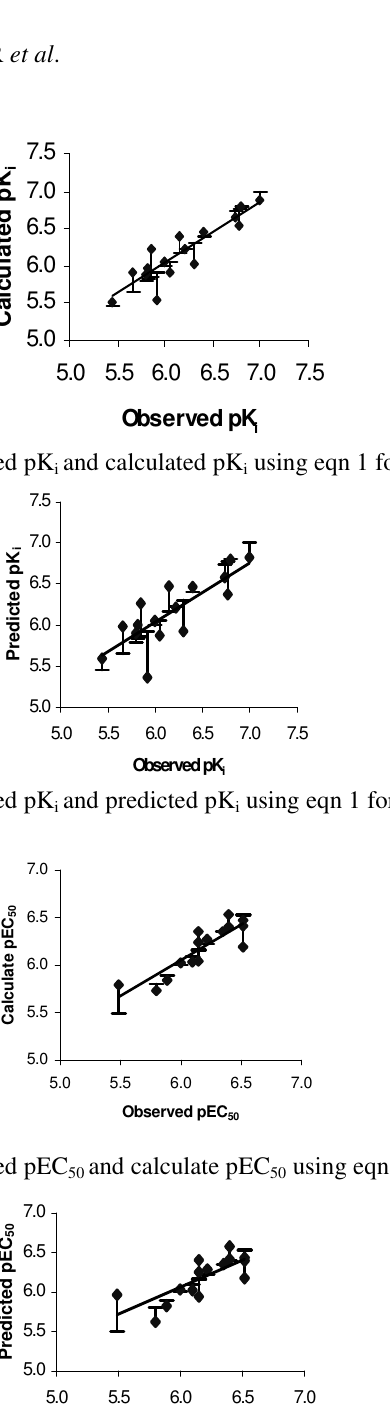
and predicted pEC 50